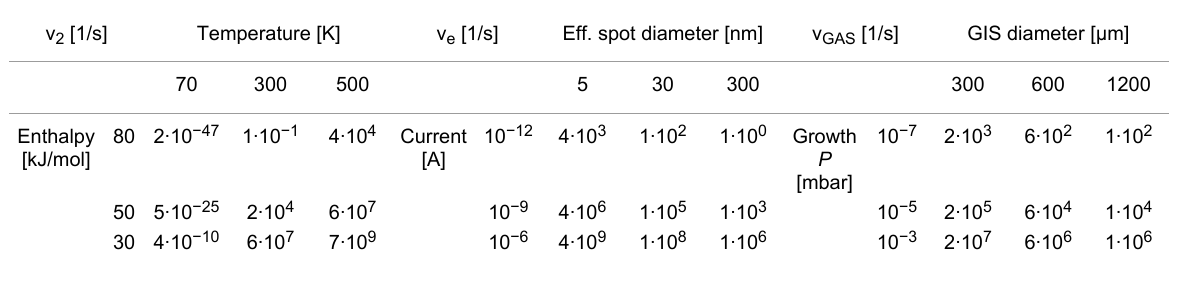
Table 1: Examples of ν 2 , ν e and ν GAS values for standard experimental FEBID conditions. σ = 5·10 − 21 m 2 for Co 2 (CO) 8 is used from [19]. F is calcu- lated for a Helios FEI dual beam system with a Pfeiffer TMH 262 turbo-molecular pump. Typical vaporization enthalpy values for FEBID precursors, associated to E 2 , are taken from [1]. Chemisorption energies E 1 are significantly greater than E 2 [1], leading to v 2 << v 1 . See the spreadsheet in Sup- porting Information File 2 for more